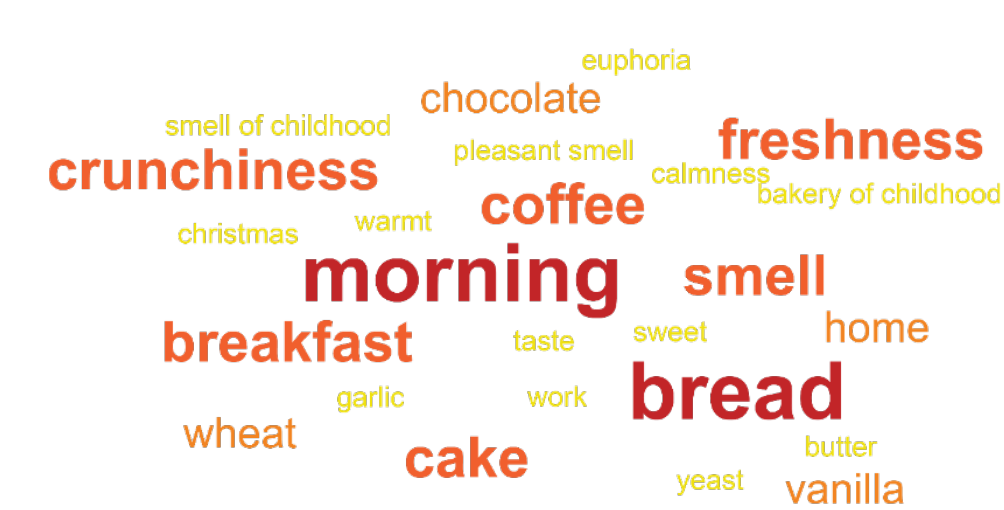
Figure 7. Associations with the department of pastry and bakery products.